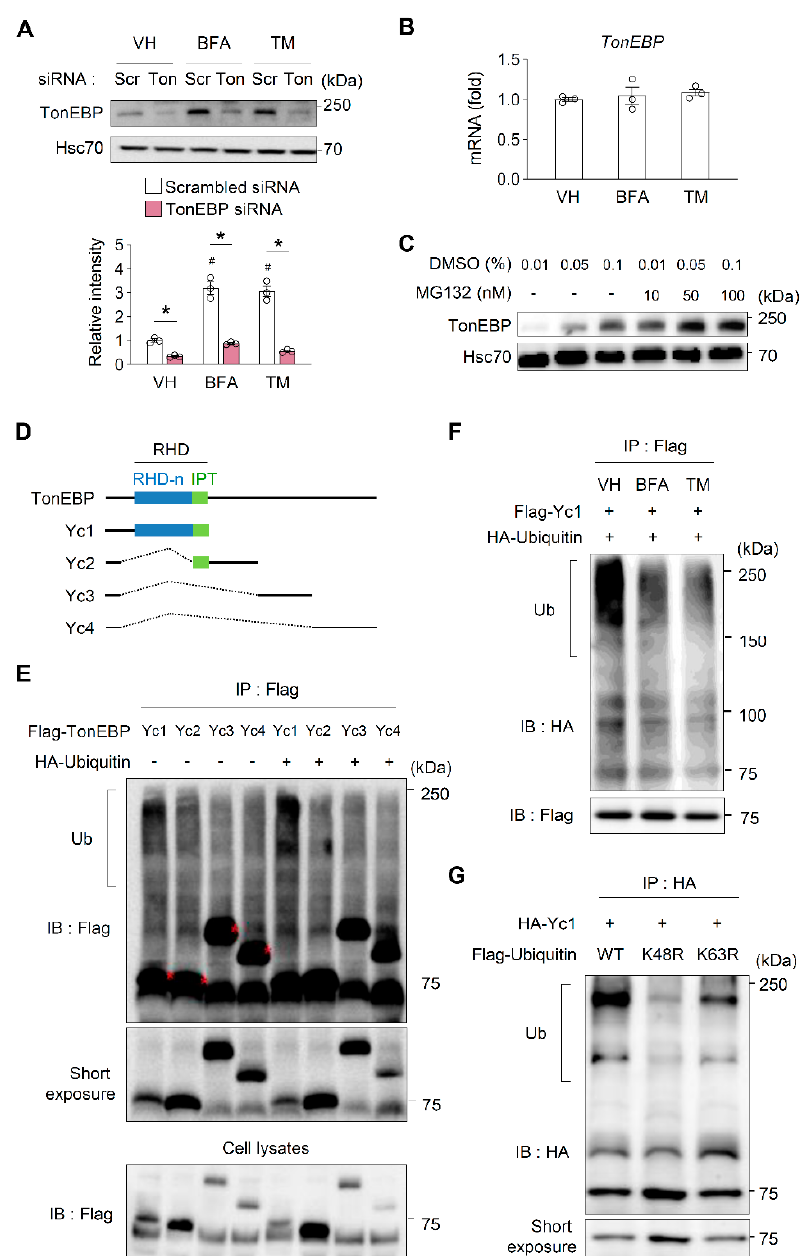
Figure 5. ER stress dramatically increases TonEBP protein stability. ( A ) MIN6-M9 cells transfected with scrambled siRNA (scr) or TonEBP-targeted siRNA (Ton) were treated for 4 h with vehicle (VH), brefeldin A (BFA; 20 µ M), or tunicamycin (TM; 1 µ g / mL) as indicated. TonEBP and Hsc70 were immunoblotted. Data (mean + SD) were from three independent experiments ( n = 3) each with more than three replicates. # p < 0.05 vs. scrambled siRNA-VH. * p < 0.05 (one-way ANOVA). ( B ) Cells were treated for 6 h with the same agents as in ( A ). TonEBP mRNA was measured by RT Q-PCR. Mean + SD, n = 4. ( C ) Cells were treated for 4 h with 10–100 nM MG132 or 0.01–0.1% of DMSO (vehicle) as indicated. ( D ) Structures of human TonEBP and their serial deletion constructs Yc1, Yc2, Yc3 and Yc4. ( E ) HEK293 cells were transfected with plasmid expressing Flag-tagged Yc1, Yc2, Yc3 or Yc4 alone or in combination with another plasmid expressing HA-ubiquitin as indicated. Proteins immunoprecipitated with an anti-Flag antibody were immunoblotted with the same antibody. ( F ) Cells were transfected with two plasmids expressing Flag–Yc1 and HA–ubiquitin. Cells were the treated for 1 h with agents shown in ( A ). Proteins immunoprecipitated with an anti-Flag antibody were immunoblotted with an anti-HA antibody. ( G ) HEK293 cells were transfected with HA–Yc1 together with Flag–ubiquitin (WT), Flag–ubiquitin K48R mutant (K48R) or Flag–ubiquitin K48R